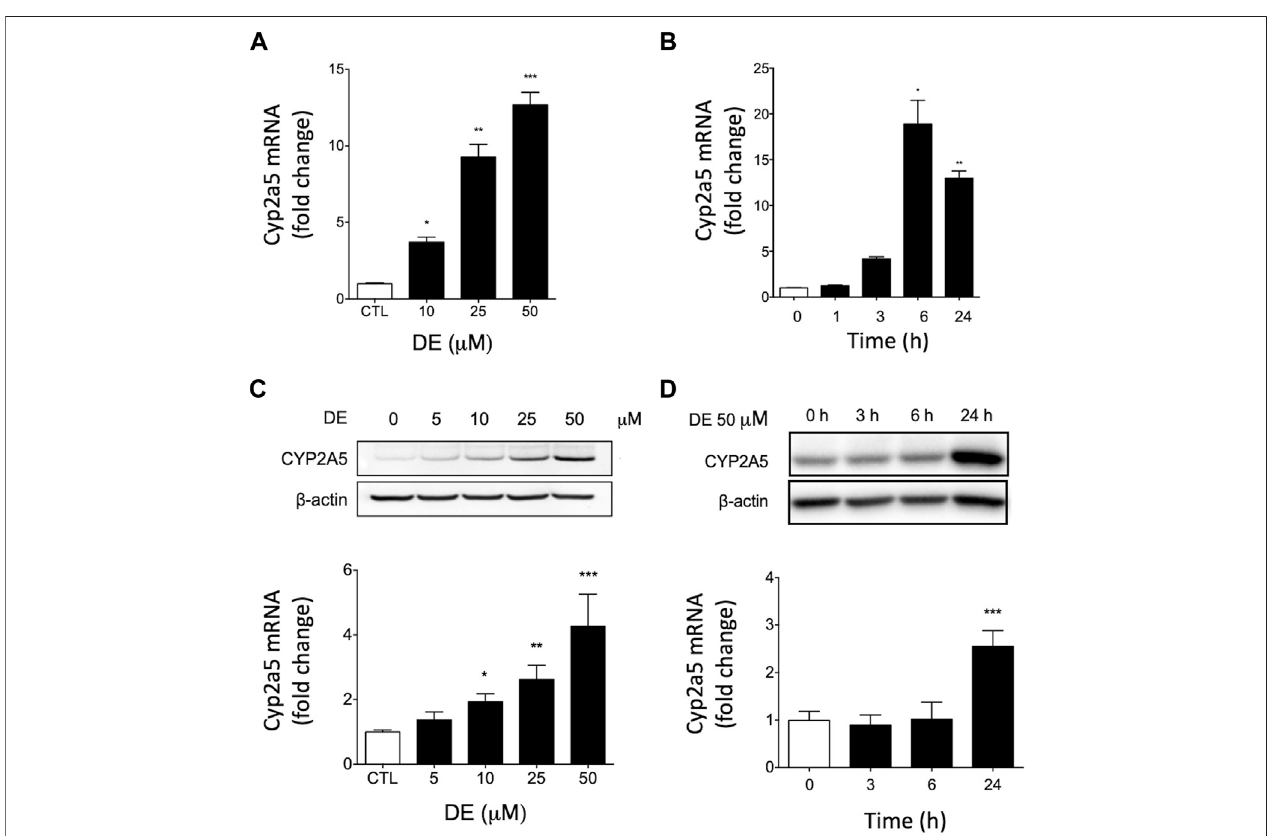
FIGURE 4 | DE increases Cyp2a5 mRNA and protein levels in primary mouse hepatocytes. Primary mouse hepatocytes were treated with increasing doses of DE orthevehiclefor24 horat50 μ Mforspeci fi ctimesupto24 hCyp2a5mRNA(Panels (A) and (B) )andproteinlevels(Panels (C) and (D) )weredetermined.Densitometric quanti fi cation of Cyp2a5 and β -Actin protein levels is presented as the mean fold-change ± SEM of the Cyp2a5/ β -actin ratio relative to the control. Values represent means ± SEM of data generated from three independent experiments (n (cid:2) 3) performed in triplicate. The mean difference is signi fi cant from controls at p ≤ 0.05 *, p ≤ 0.01 ** and p ≤ 0.001